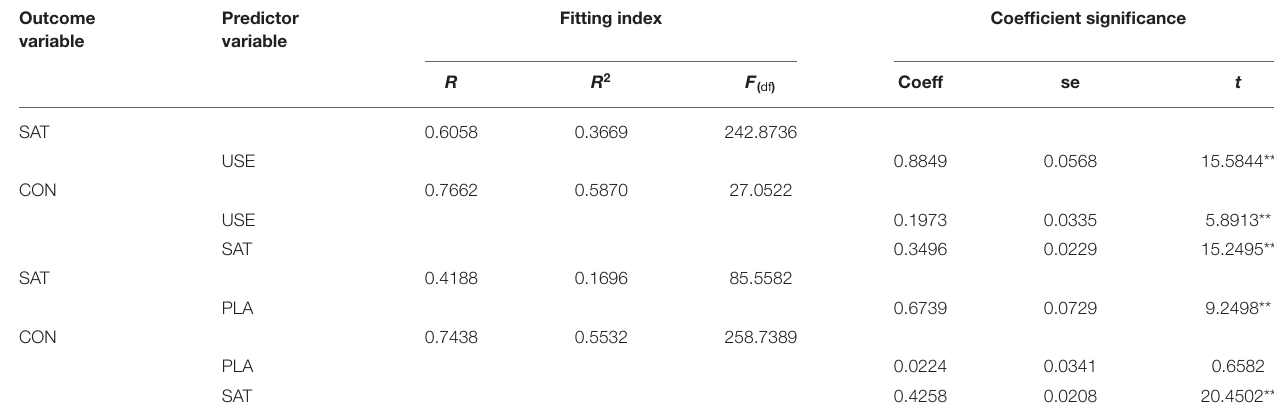
TABLE 6 | The mediation model testing of